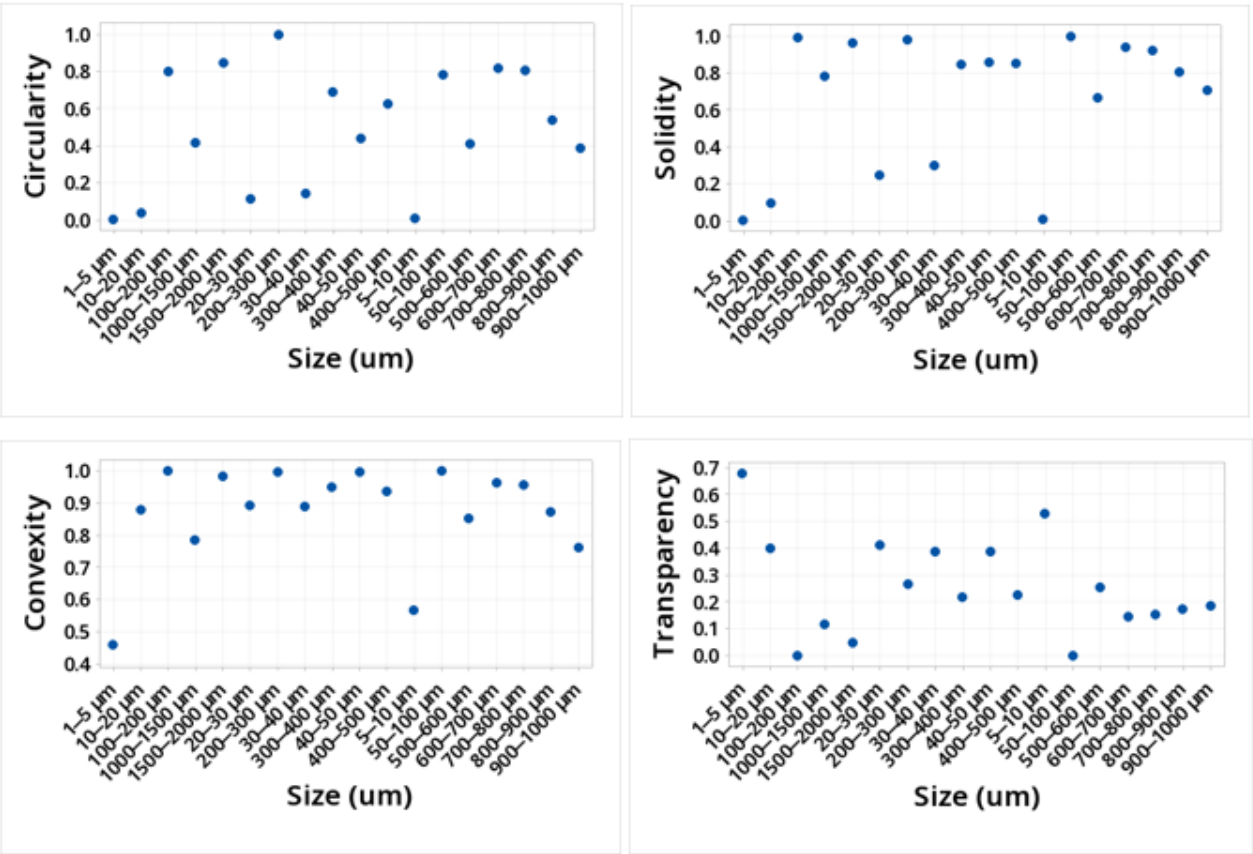
Figure 4. Values of circularity, solidity, convexity, and transparency for the MPs identified. Table 1. Values of morphological parameters for the MPs identified.